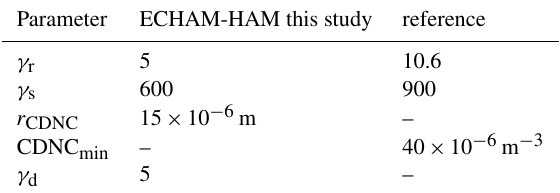
Table A1. Tuning parameters that differ between this study and the reference of Neubauer et al. (2019). γ r is the scaling factor for the stratiform rain formation rate by autoconversion. γ s is a scaling fac- tor for the stratiform snow formation rate by autoconversion. With the changes described in Sect. 2.1 the tuning parameter of the maxi- mum cloud droplet radius, r CDNC , replaces the previous minimum cloud droplet number concentration, CDNC min . The tuning param- eter for immediate autoconversion of detrained ICNC, γ d , is newly introduced.